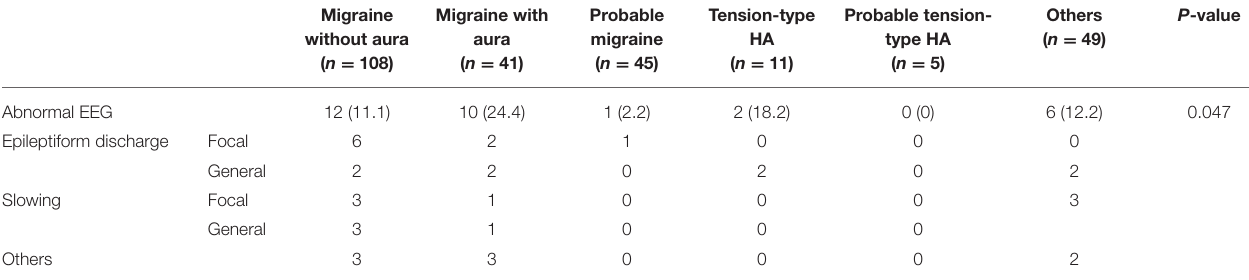
TABLE 2 | Electroencephalogram (EEG) findings according to headache types in the